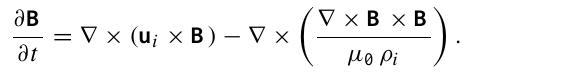
Fig. 4. Snapshot of the three-dimensional calculation at 1.30AU for the 4 π case which shows the magnetic field in nT. The drawn planes are the orthogonal planes of the coordinate axes. The solar wind enters the box from the left side in +x-direction. The pre- dominant transport of the magnetic field in − z-direction is clearly visible. Furthermore, we discern the formation of a region depleted in the magnetic field behind the +z-axis. This indicates a low degree of mixing between the solar wind and cometary species, so that the magnetic field remains bound to the solar wind flow which leads to the pileup in front of the obstacle.